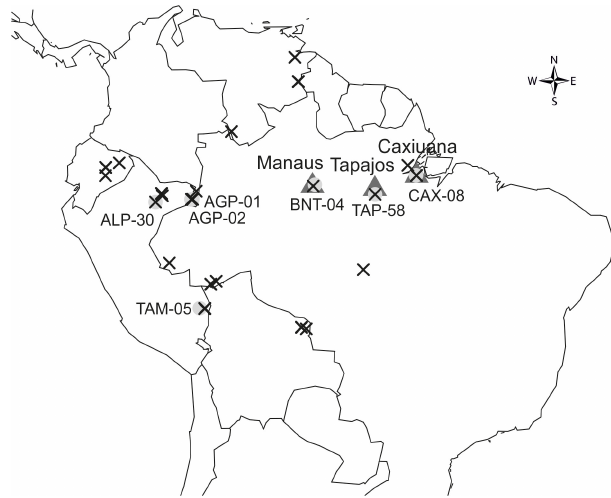
Figure 2. Geographic distribution of study sites. Dark grey triangles indicate the three eddy flux tower sites (with local names), light grey circles indicate the seven intensive measurement plots (with plot codes), and crosses indicate the coordinates of the 40 RAINFOR permanent measurement